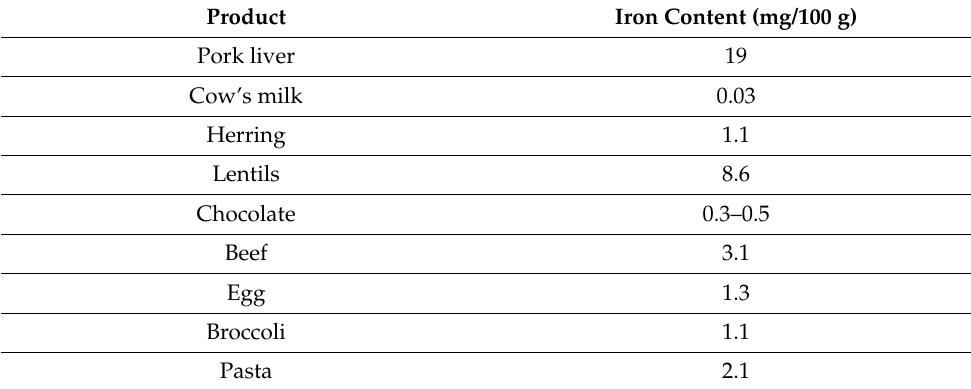
Table 3. Content of iron in chosen food products